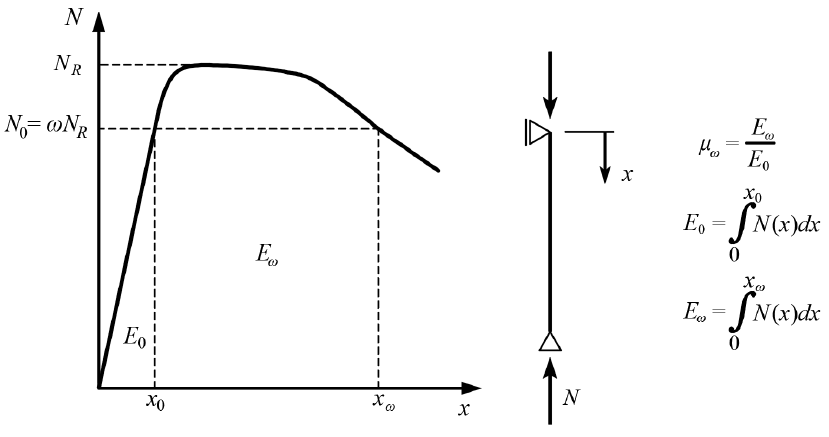
Figure 8. Proposed measure of vertical ductility based on the energy.